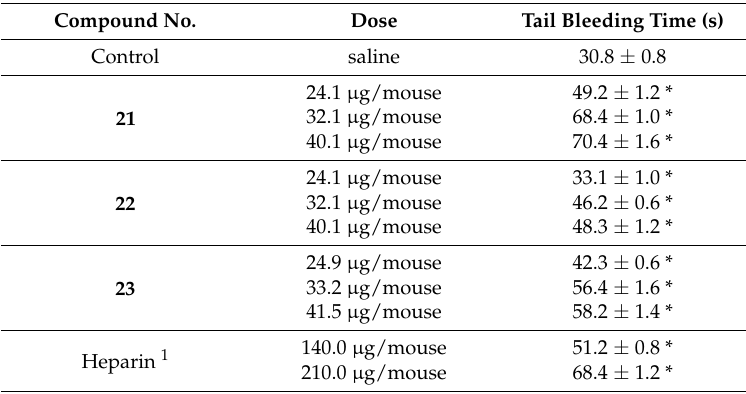
Table 7. In vivo bleeding time of amidino N 2 -thiophene compounds 21 – 23 .